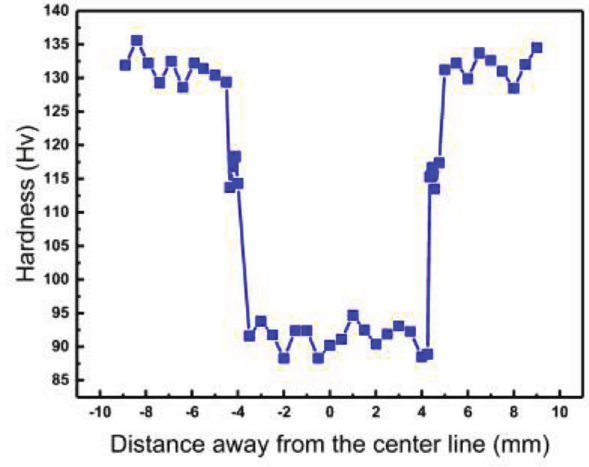
Figure 8: Hardness profile of the FZ and the HAZ of the DWMW